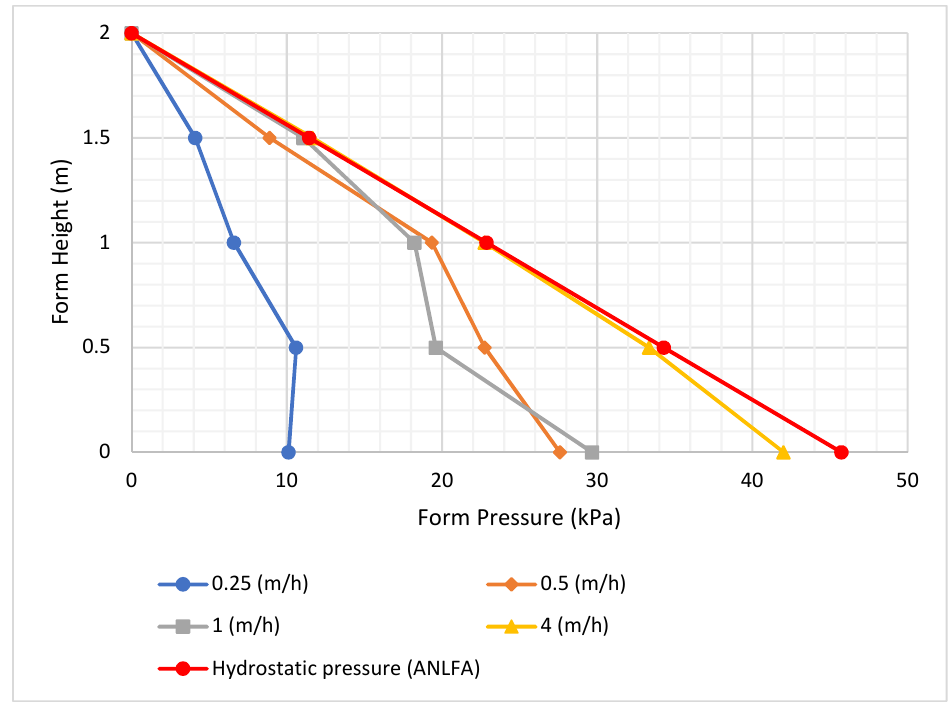
Figure 4. The effect of casting rate on pressure.